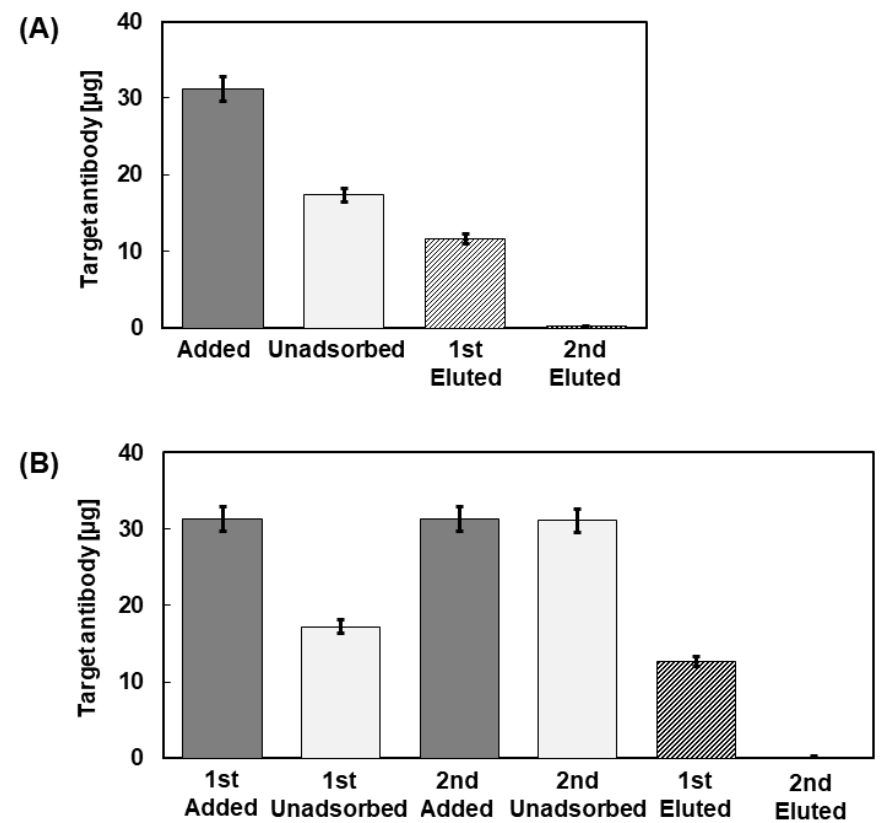
Figure 6. Assay of the antibody adsorbed onto CA/PVA + PA NF. The amounts of antibody adsorbed and eluted were evaluated by ELISA. ( n = 3) ( A ) Once adsorption and following two elution processes. ( B ) Repetitive adsorption and following two elutions.